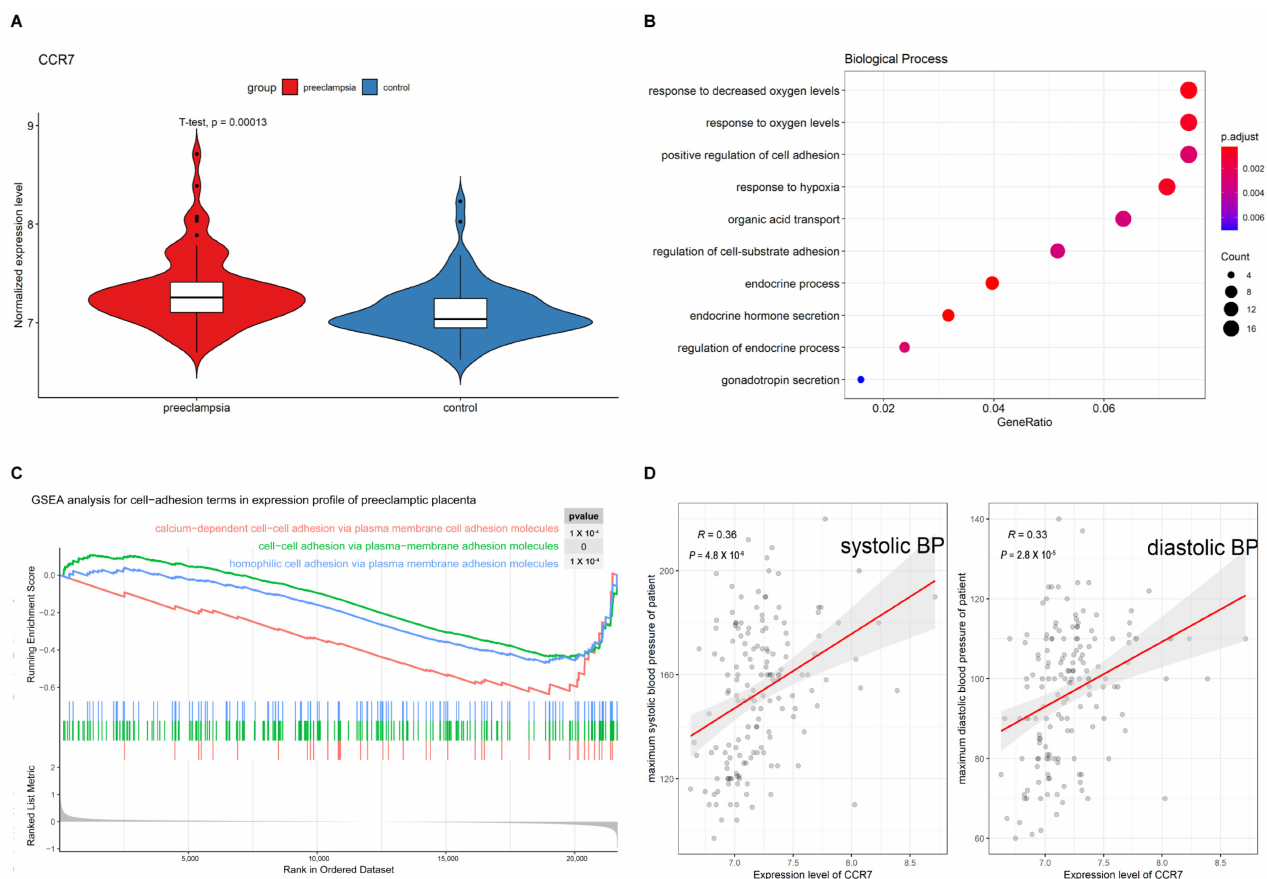
Figure 1. CCR7 is an important gene for normal pregnancy by high throughput analysis. ( A ) Expression violin pattern of CCR7 after differential expression analysis. ( B ) The most significant enriched terms in placentas. ( C ) The hallmark pathways associated with CCR7 in PE placentas. ( D ) Pearson’s correlation coefficient was used to verify the correlation between CCR7 expression level and blood pressure ( p < 0.05, R1 = 0.36, R2 =